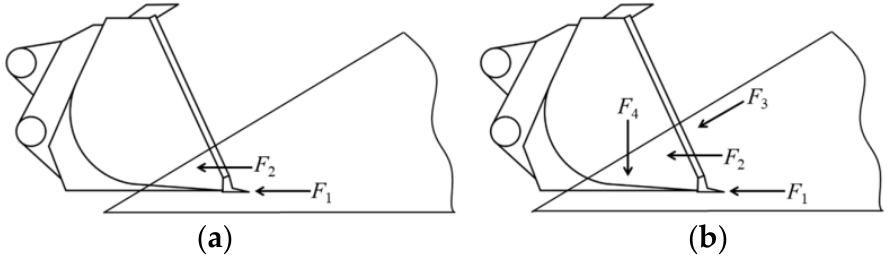
Figure 10. Wheel loader insertion process. ( a ) The pre-insertion phase; ( b ) The late-insertion phase.